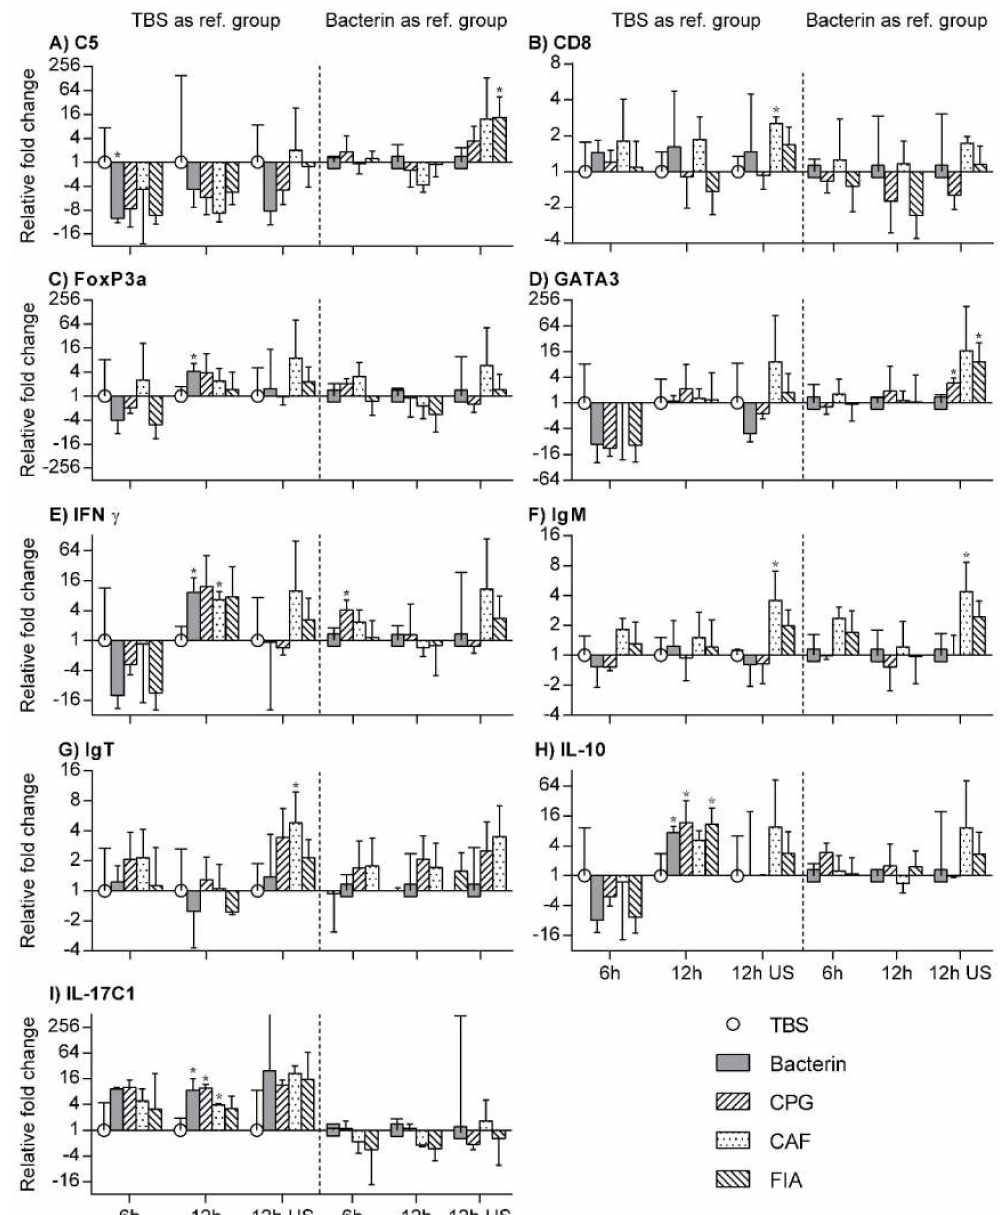
Figure 3. Comparative analysis ( A – I ) of RT-qPCR data from in vitro restimulation of isolated anterior kidney leukocytes. The x-axis denotes the duration of the restimulation (“US” denotes unstimulated cells). Each individual graph illustrates the fold change ( ± geometric mean) in the transcription of the target gene (identified in the upper left corner of each figure) for a given experimental situation and group relative to that of the TBS group (left panel, TBS group denoted by a white circle) and to that of the bacterin group right panel, bacterin group denoted by filled, grey square). *Asterisks denote a statistically significant di ff erence from the reference group